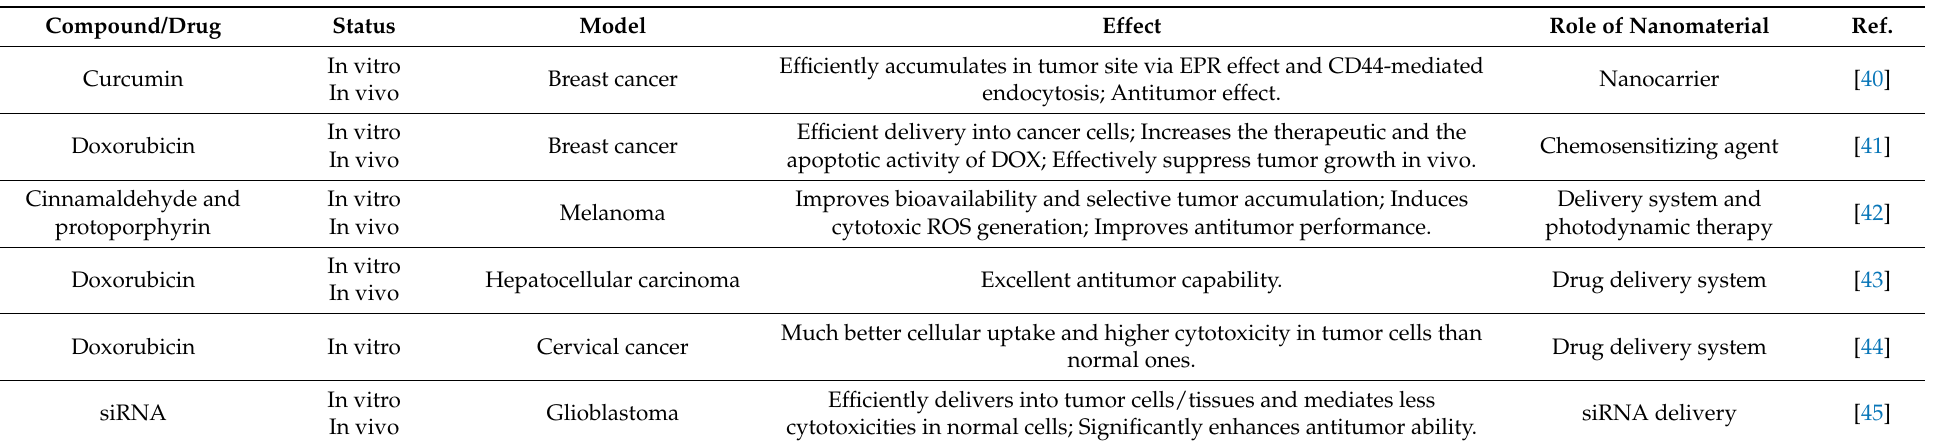
Table 1. Recent application of HA-based drug conjugates in cancer